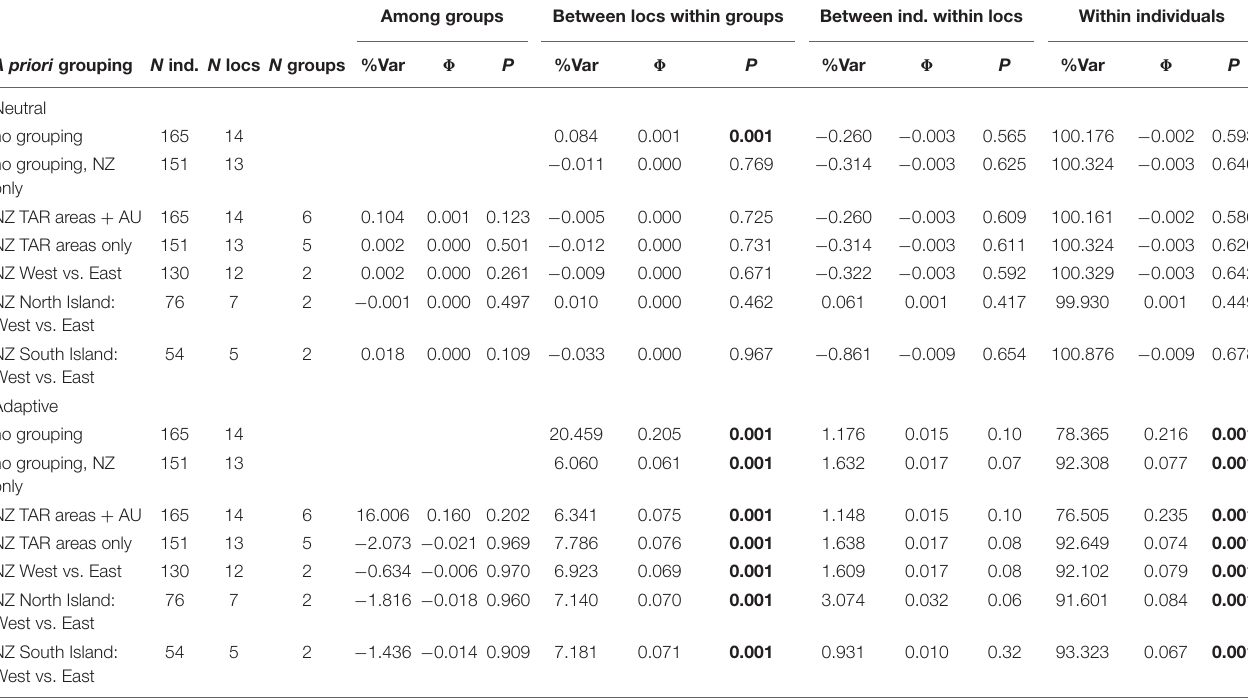
TABLE 2 | Results from analysis of molecular variance performed on the neutral and adaptive SNP datasets, with seven a priori groupings. Among groups Between locs within groups Between ind. within locs Within